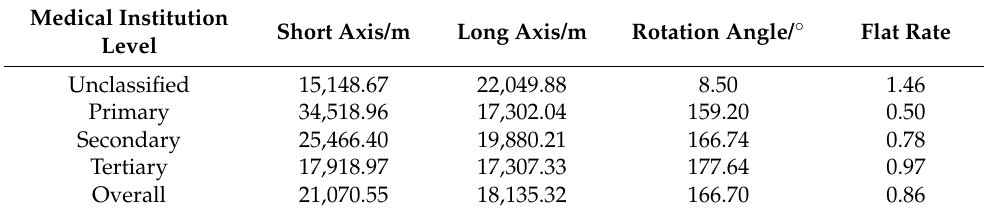
Table 1. SDE information of different levels of medical institutions. Medical Institution Short Axis/m Long Axis/m Rotation Angle/ Level